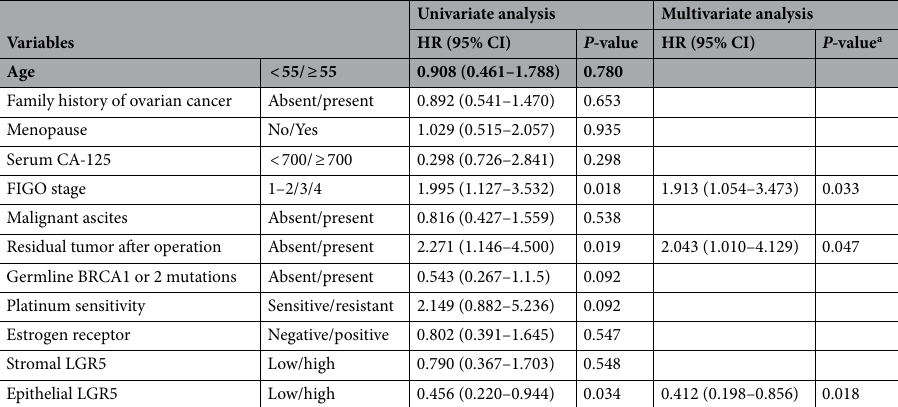
Table 2. The univariate and multivariate analysis for progression free survival rate for high-grade serous carcinomas. HR Hazard ratio; CI confidence interval; FIGO International Federation of Gynecology and Obstetrics. a Cox proportional hazard